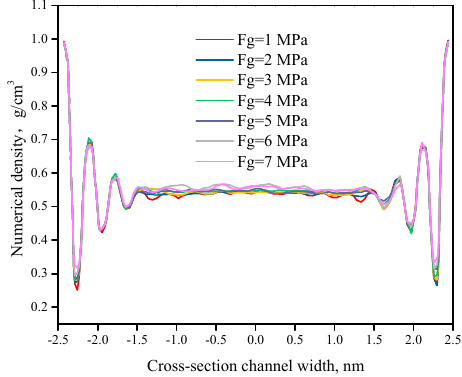
Figure 8. Numerical density curve of the polymer under different external pressures.